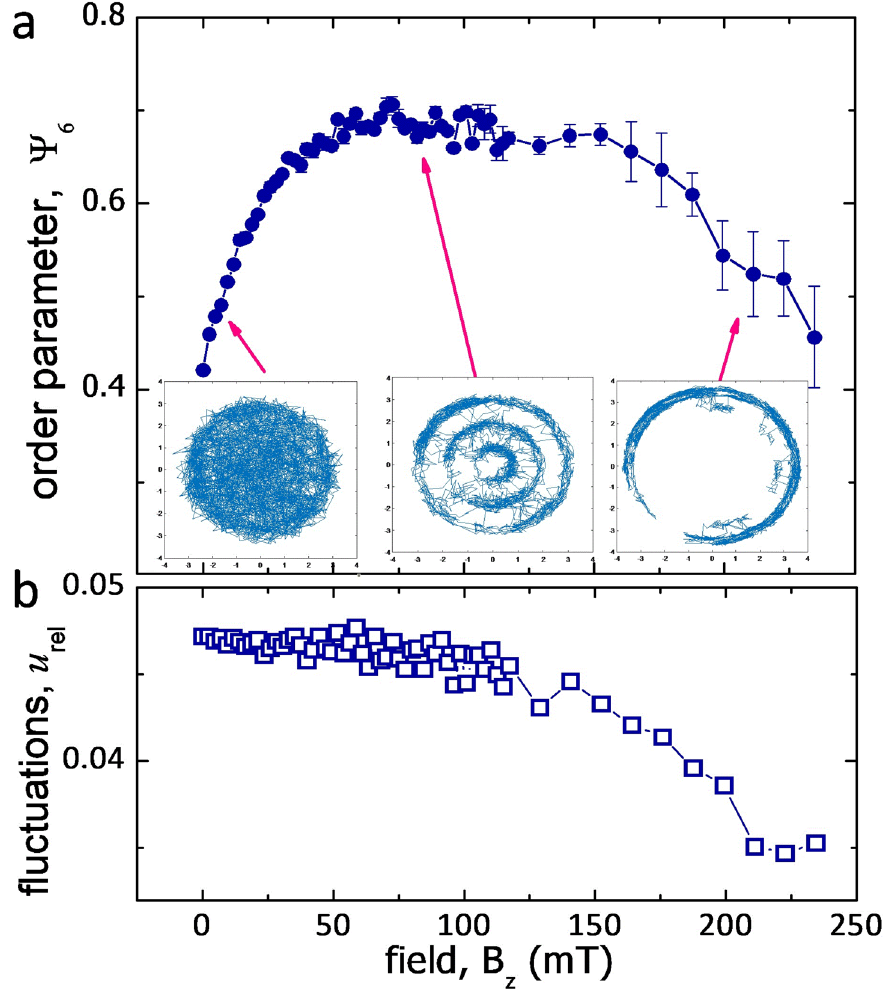
Fig. 5 Field-induced crystallization process. a Average orientational bond order parameter 〈 Ψ 6 〉 versus amplitude B z of the applied fi eld for a N = 29 nanoparticle cluster. Small insets are snapshots from numerical simulations of one particle trajectory at B z = 7.3mT (left), B z = 82.4mT (center) and B = 210.9mT (right). b Interparticle distance fl uctuations u z